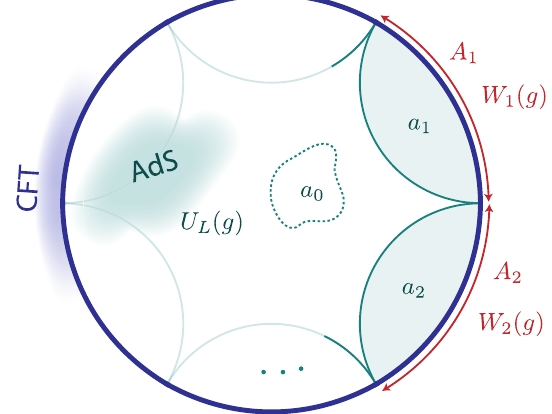
FIG. 6. Nontrivial bulk global symmetries are incompatible with the AdS/CFT quantum error-correcting code. A bulk global g Þ corresponds to a boundary global symmetry operator U L ð g Þ which is transversal with respect to symmetry operator U CFT ð the decomposition of the boundary into subregions f A : k g U g Þ ¼ ⊗ W g Þ , where W g Þ is supported on A . The bulk k ð k ð k CFT ð k subregion a 0 is outside the entanglement wedge a of each k boundary subregion A ; therefore, erasure of each A is correct- k k able for the algebra A of bulk local operators on a 0 . Furthermore, g Þ maps low-energy states of the boundary CFT to low- each W k ð g Þ is a logical operator energy states. This result means that W k ð which preserves the code space of the CFT. A logical operator W g Þ supported on a correctable boundary subregion A must be k ð k the logical identity. Therefore, the global symmetry operator U g Þ acts trivially on bulk local L ð